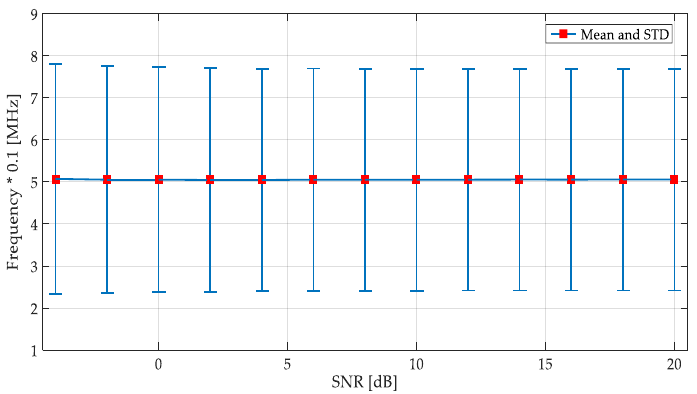
Figure 15. Study of frequency edge detection applying the first methodology.